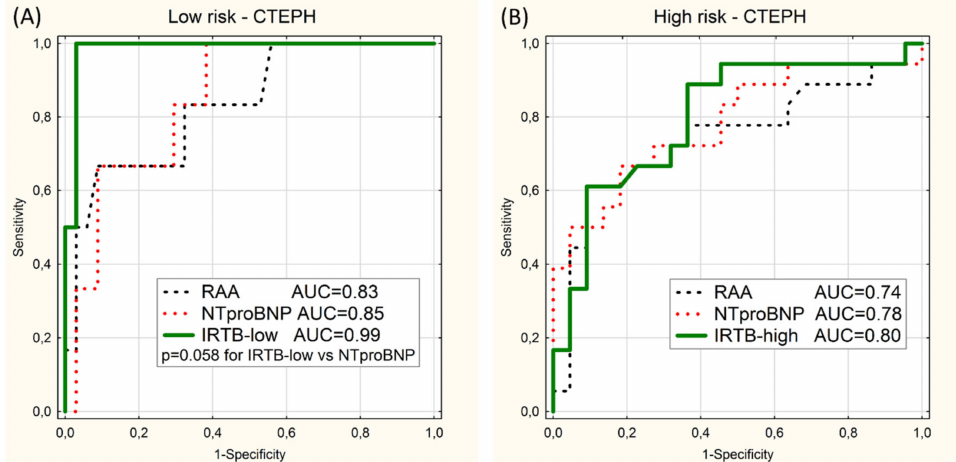
Figure 4. ROC curves for prediction of the low-risk category ( A ) and the high-risk category ( B ) in the CTEPH subgroup using 2 univariable models (RAA and NTproBNP) or the multivariable model (IRTB-low or IRTB-high). Values of area under curves (AUC) and p -value close to significance level ( p ) are